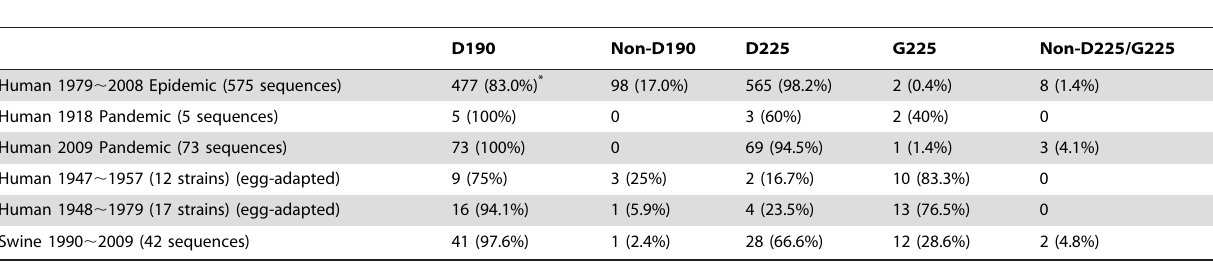
Table 6. Codons at HA 1 190 and 225 in human and swine A(H1N1) influenza